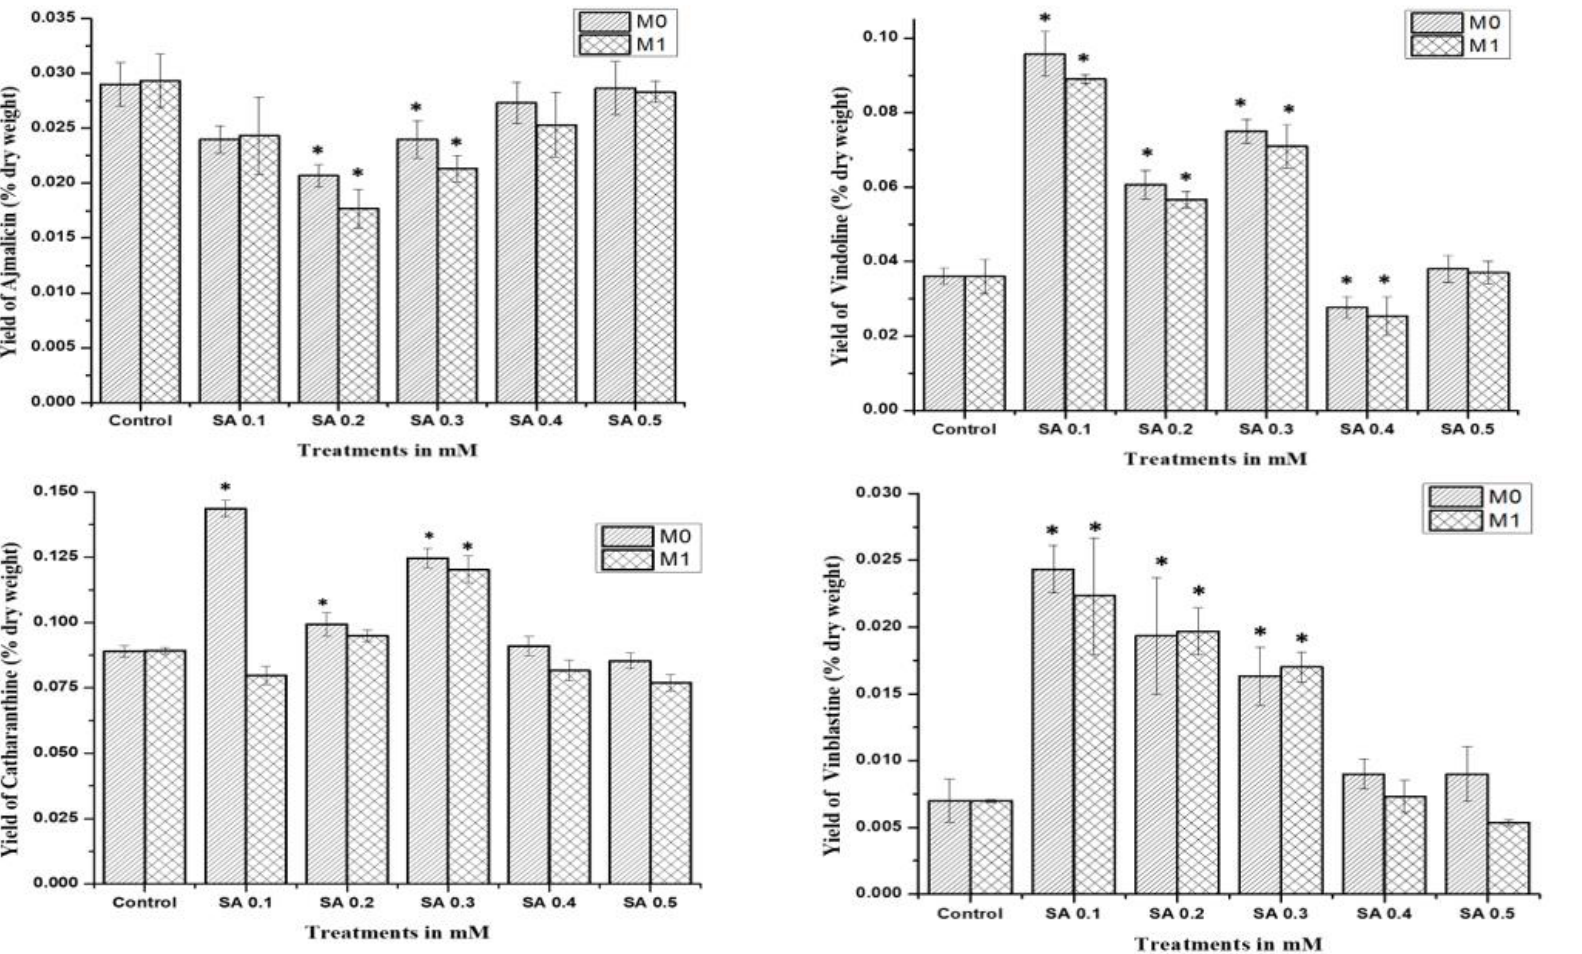
Figure 4. HPLC analysis of the key MIAs ajmalicine, catharanthine, vindoline, and vinblastine in SA-mutated M 0 –M 1 and control C. roseus plants. * represents a significant difference from the respective control at p < 0.05 after applying post hoc Dunnett’s test ( n = 3).